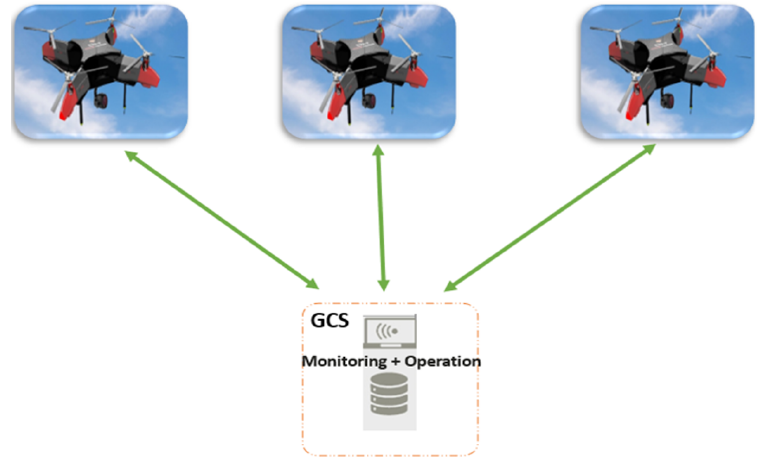
Figure 2. Block diagram of infrastructure (GCS)-based swarm